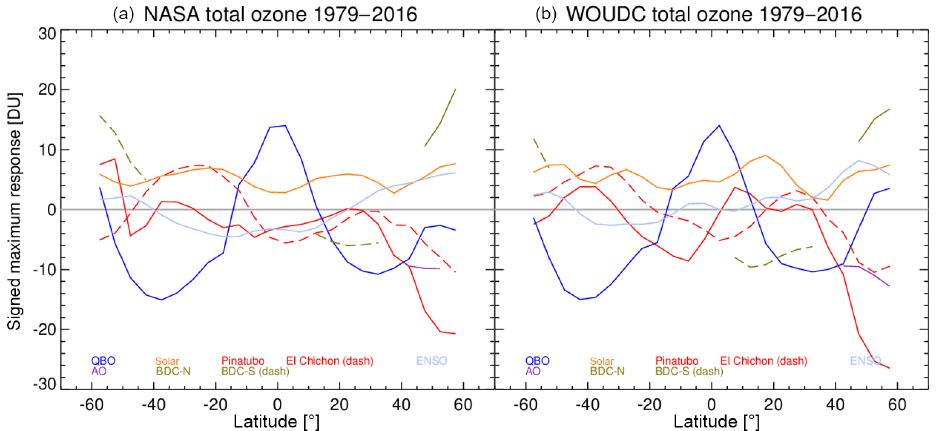
Figure 10. Signed maximum response during the period 1979–2016 from various factors (terms) in the MLR. (a) NASA data; (b) WOUDC data. Negative values mean that total ozone is anticorrelated with the corresponding proxy (factor). Maximum response is the difference between the maximum and minimum values of the regression term in the MLR time series. Note that, in the MLR regression, negative values of the BDC-S proxy are used, meaning that positive values correspond to enhanced BDC driving in both hemispheres. Table 4. The 2000–2016 polar total ozone trends in March (NH), September (SH), and October (SH). Uncertainties are provided for 2 σ and trends in bold indicate statistical significance. r 2 is the squared Pearson correlation and χ the residual (see caption of Table 3). The results were obtained from the standard MLR with the respective hemispheric BDC term added. Zonal bands